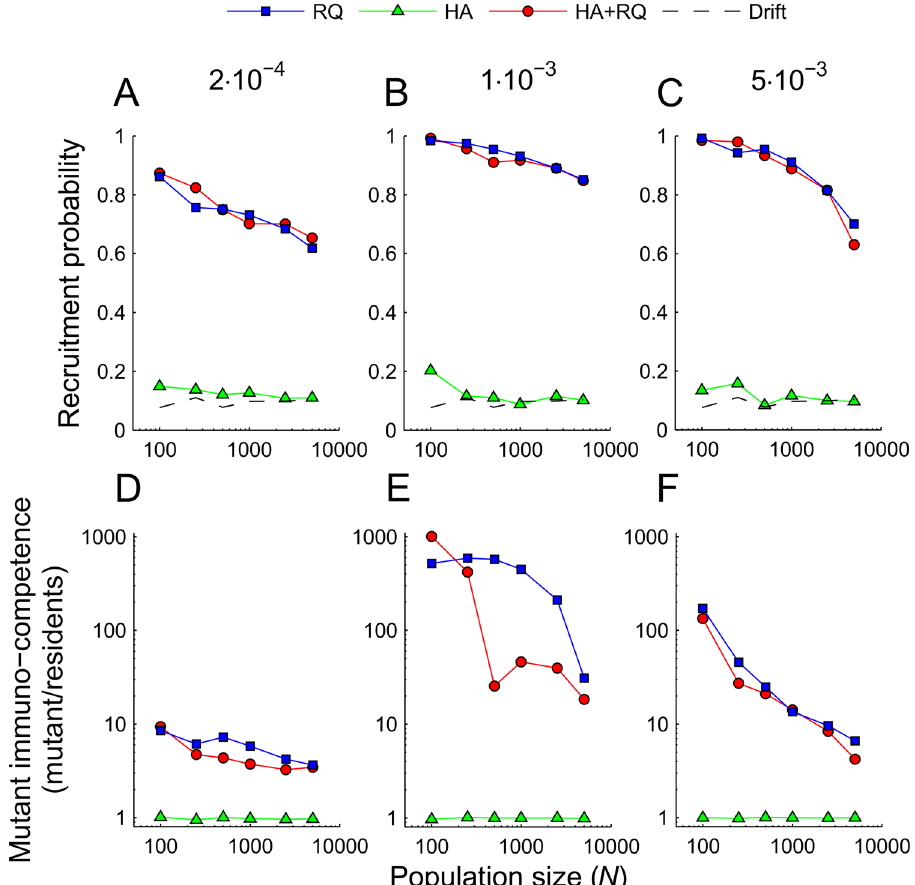
Fig 3. Presentation ability and probability of recruitment of a new mutant MHC allele. (A-C) Data points indicate the probability that a mutant allele will stay in the population for at least 10 host generations (cut-off points longer or shorter than 10 generations (e.g., 2 or 20) showed similar patterns). (D-F) Data points indicate the relative pathogen-recognition ability of a mutant MHC allele relative to the immunocompetence of resident alleles. The average immunocompetence of resident alleles was measured as the number of pathogens recognized in a given generation, weighted by the frequency of each resident allele. Note that a presentation spectrum equal to 1 indicates the threshold at which a mutant allele is able to present, on average, the same proportion of pathogens as resident alleles are. (A-F) Characteristics were calculated across the last 6000 generations of 10 replicates. Scenario labels: HA – heterozygote advantage, RQ – Red Queen, HA+RQ – both. Pathogen mutation rates are given above the